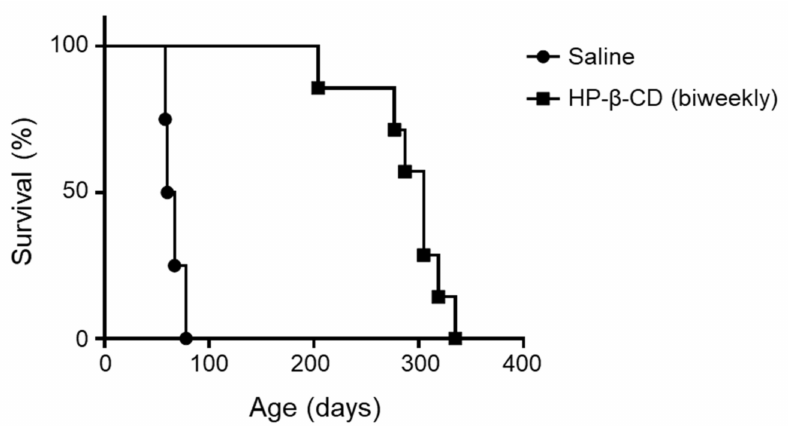
Figure 5. Life-prolonging effect of intracerebroventricular administration of 2-hydroxypropyl- β - cyclodextrin (HP- β -CD) in Npc1 − / − mice. HP- β -CD treatment (21.4 µ mol/kg) was started at 4 weeks of age, with repeated injection into the mice every 2 weeks. Kaplan–Meier survival curves for the Npc1 − / − mice are shown ( n = 4 for the saline-treated group (circle) and n = 7 for the HP- β -CD (biweekly) group (square)). A significant difference between the two groups was identified by the log-rank test ( p <